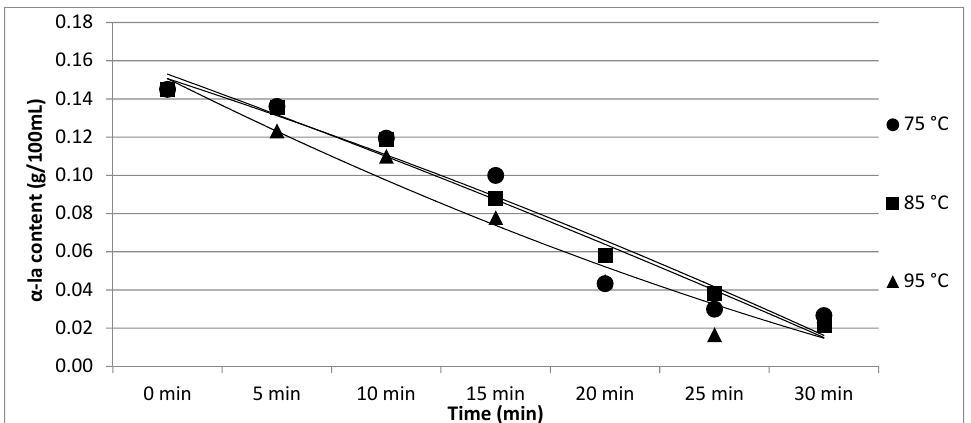
Figure 10. Effect of heating temperature and time on β -lg content. Equations: 75 °C (y = − 0.0004x 2 − 0.0202x + 0.1735; R 2 = 0.9373), 85 °C (y = − 0.0006x 2 − 0.0175x + 0.1688; R 2 = 0.9845), 95 °C (y = 0.001x 2 − 0.0305x + 0.1802; R 2 = 0.9566). Table 3. Results of two-way ANOVA.